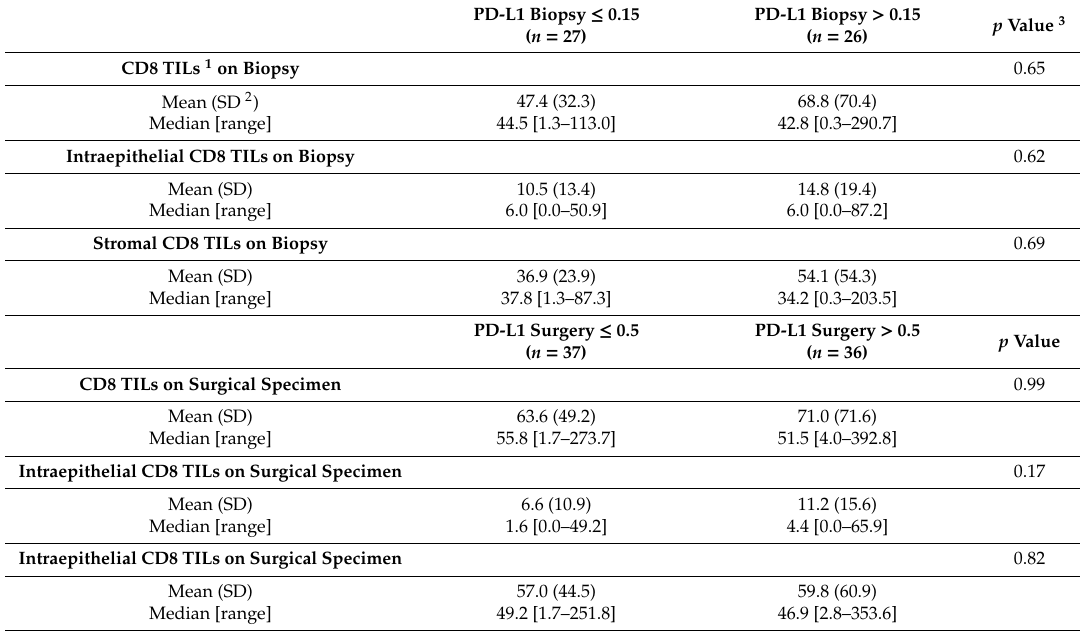
Table 3. Relation between CD8 TILs infiltration and PD-L1 + cells median values at pre-treatment (biopsy) and post-treatment (surgical